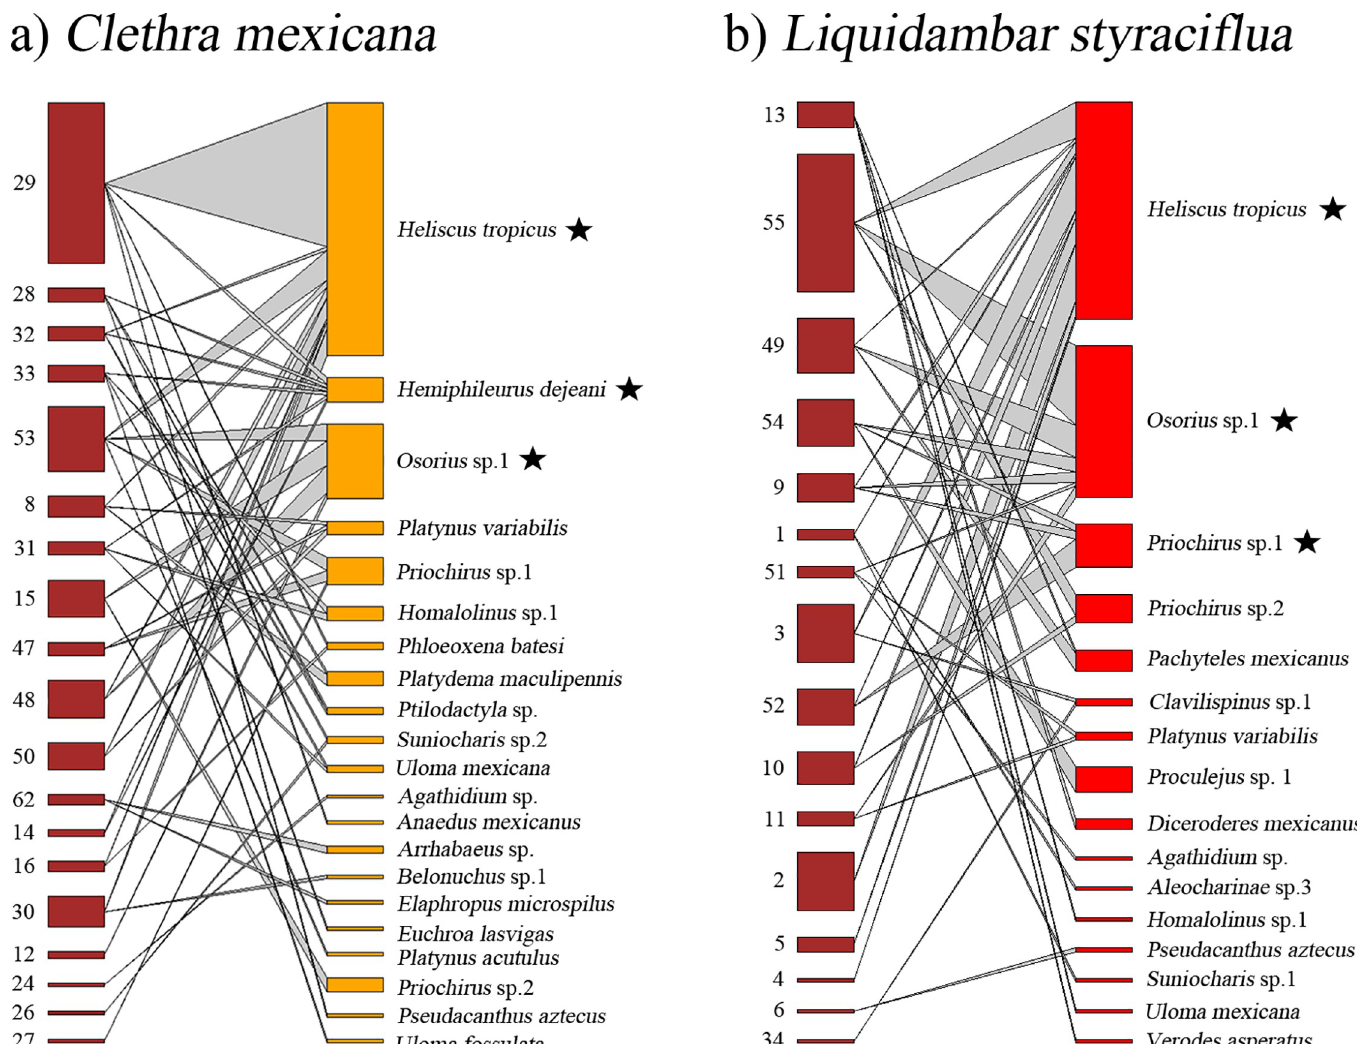
Fig 2. Saproxylic beetle network between two tree species. Differences in core composition related to a) Clethra mexicana and b) Liquidambar styraciflua tree species. Nodes on the left correspond with each sampled trunk and nodes on the right represent the saproxylic beetle species. Species that constitute the core of the network are highlighted with a black